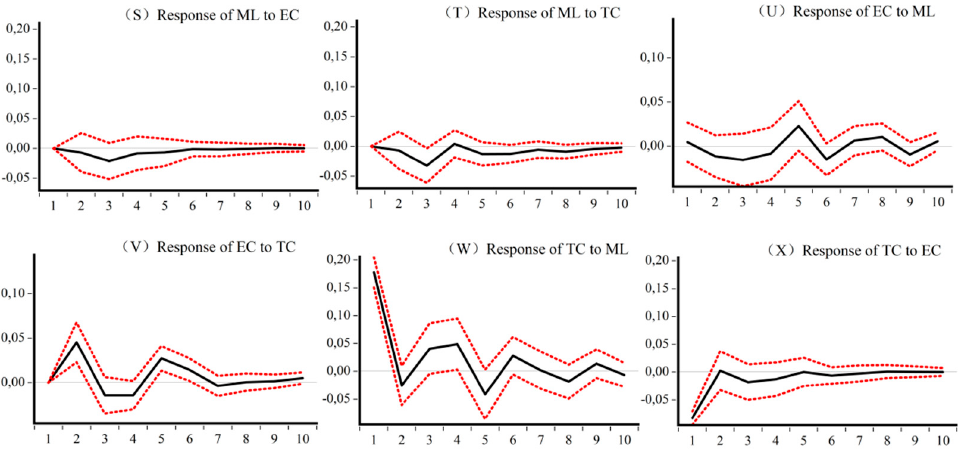
Figure 8. Impulse response results of ML, EC, and TC of Western CEE. ( S ) Response of ML to EC ( T ) Response of ML to TC ( U ) Response of EC to ML ( V ) Response of EC to TC ( W ) Response of TC to ML ( X ) Response of TC to EC.